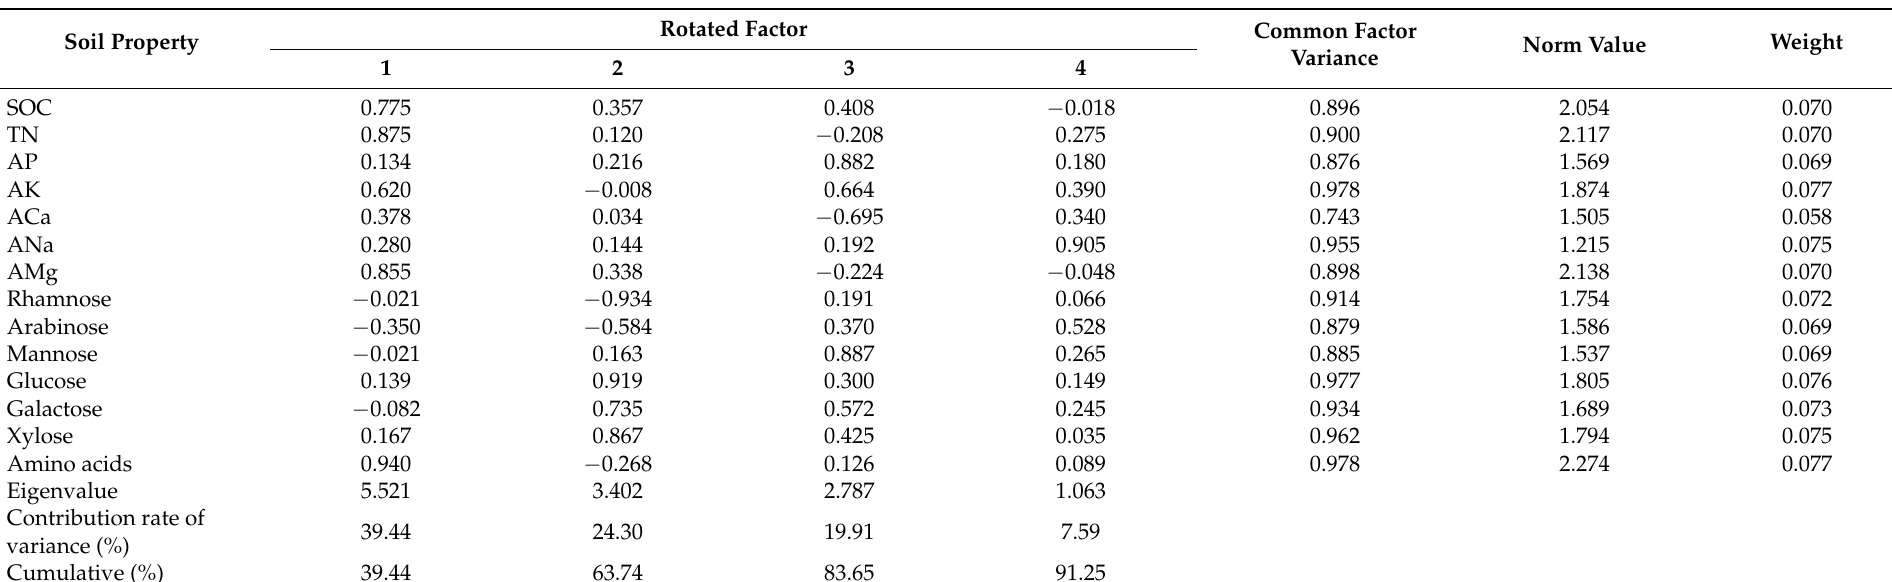
Table 5. Rotated factor capacity, weight, eigenvalue and contribution rates in principal component analysis of soil quality factors. Soil